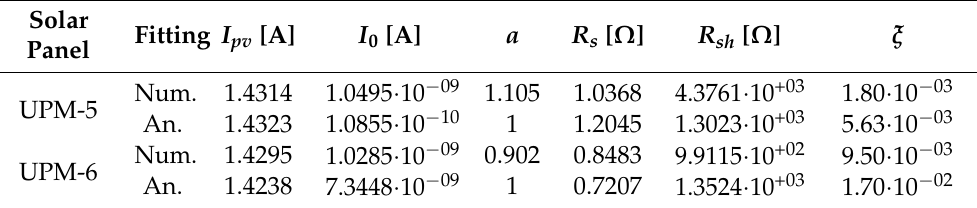
Table 6. Parameters for the 1-D/2-R equivalent circuit model (where Num. represents the numerical best fit, and An. represents the analytical fit with a = 1) for the UPM-5 and UPM-6 solar panels of the UPMSat-1 satellite. ξ is the non-dimensional RMSE for the experimental